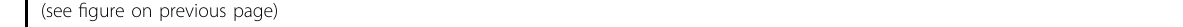
Fig. 1 Analysis of IKZF1 and IKZF3 expression. Thirteen B-cell leukemia cell lines; 7 Ph-positive consisting of KOPN30bi (Ph1), KOPN55bi (Ph2), KOPN57bi (Ph3), KOPN66bi (Ph4), KOPN72bi (Ph5), KOPN83bi (Ph6), and KCB1 (Ph7) and 6 Ph-negative consisting of 2 TCF3-PBX1 positive, 3 ETV6- RUNX1 positive, and MLL-ENL positive, were used for analysis. A RT-PCR analysis of IKZF1 isoforms in B-cell leukemia cell lines. Primer sequences for RT-PCR analysis of IKZF1 were as follows: forward primer 5 ′ -AAAGCGCGACGCACAAATCC-3 ′ , reverse primer 5 ′ -ATGGCGTTGTTGATGGCTTGGTC-3 ′ 45 . B Western blot analysis of IKZF1 expression before and after LEN treatment. B-cell leukemia cell lines were cultured for 24 h in the presence or absence of 10 µM LEN (Cayman Chemical, Ann Arbor, MI), and IKZF1 expression was examined on western blot. Anti-IKZF1 antibody was obtained from R&D Systems (Minneapolis, MN). C RT-PCR analysis of IKZF3 isoforms in B-cell leukemia cell lines. Primer sequences for RT-PCR analysis of IKZF3 were as follows: forward primer 5 ′ -ATGGAAGATATACAAACAAATGCGGA-3 ′ ), reverse primer 5 ′ -AGAGAGGCCTGTGTGAGAAGGCAC-3 ′ 46 . D Western blot analysis of IKZF3 expression before and after LEN treatment. B-cell leukemia cell lines were cultured for 24 h in the presence or absence of 10 µM LEN, and IKZF3 expression was examined on western blot. Anti-IKZF3 antibody was obtained from Proteintech (Rosemont, IL). E Comparison of decrease in IKZF1 and IKZF3 expression after LEN treatment in B-cell leukemia cell lines. In B and D , areas of IKZF1 (excluding Ik6) and IKZF3 were quanti fi ed by densitometry, and %decrease after LEN treatment was calculated as {1 − [(area of LEN + )/(area of LEN − )]} × 100. The results were shown by box- whisker plots. Comparison was done by Mann – Whitney U test. Left panel: the %decrease in IKZF1 expression in Ph + group A cell lines ( n = 4, median 90.4, range 78.4 – 99.9) was signi fi cantly ( p < 0.01) greater than that in non-Ph cell lines ( n = 6, median 49.5, range 32.0 – 65.0). Right panel: the % decrease in IKZF3 expression in Ph + cell lines ( n = 6, median 85.0, range 58.7 – 89.7) was signi fi cantly ( p < 0.01) higher than that in non-Ph cell lines ( n = 6, median 50.2, range 36.3 – 67.5). F Time-course of IKZF1 and IKZF3 isoforms expression after LEN treatment. KOPN57bi cells were cultured with 10 µM LEN for 1, 3, 6, and 24 h, and changes in IKZF1 and IKZF3 expression was examined on western blot. G Effect of neddylation activating enzyme inhibitor MLN4924 on IKZF1 and IKZF3 isoforms expression after LEN treatment. KOPN57bi cells were cultured for 24 h in the presence or absence of 10 µM LEN with or without 30 min-pretreatment with 0.25 µM MLN4924 (ChemScene, Monmouth Junction, NJ), and changes in expression of IKZF1 and IKZF3 were examined on western